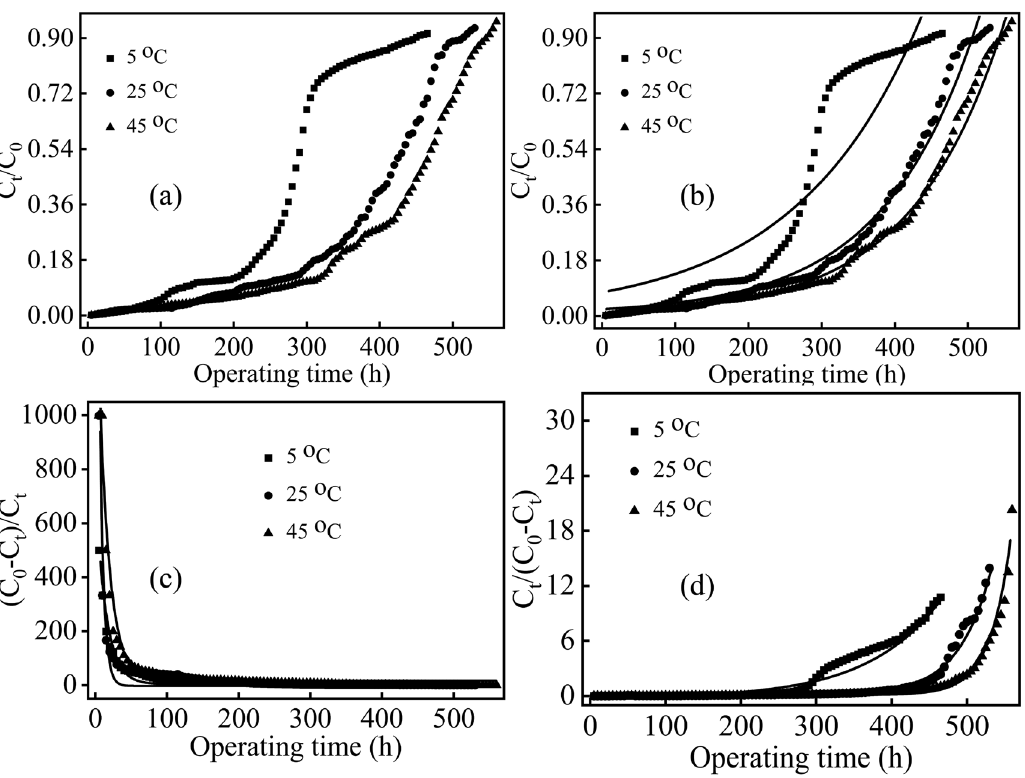
Figure 8: In fl uence of the reaction temperature on the breakthrough curves of the treatment of MG dye from aqueous solutions using ceramsite - supported nZVI in a fi xed - bed reactor ( a ) , and the fi tting results of Thomas ( b ) , Y – N ( c ) , and A – B ( d ) fi xed - bed reaction kinetic